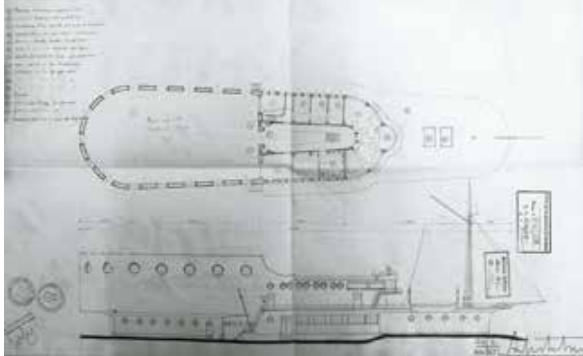
Figure 3. Vintage postcard of the 'Casa del Marinaretto' with young people wearing Navy uniform.